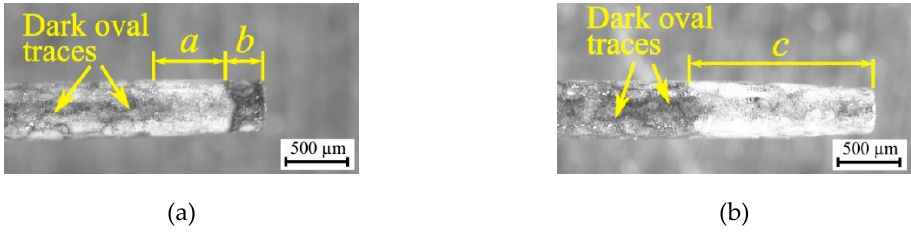
Figure 16. Photographs of tool electrode wear after drilling the holes with the machining parameters applied: ( a ) t i = 282 µs, U = 120 V, I = 4.32 A; ( b ) t i = 550 µs, U = 100 V, I = 3.83 A.